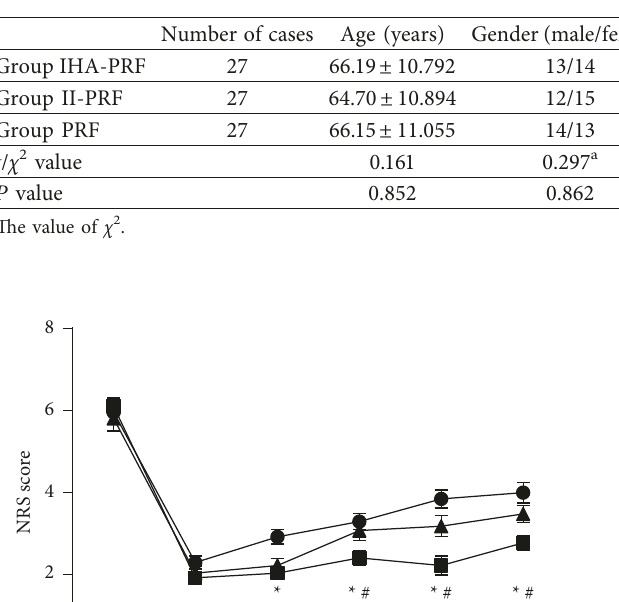
Table 1: General data of patients.